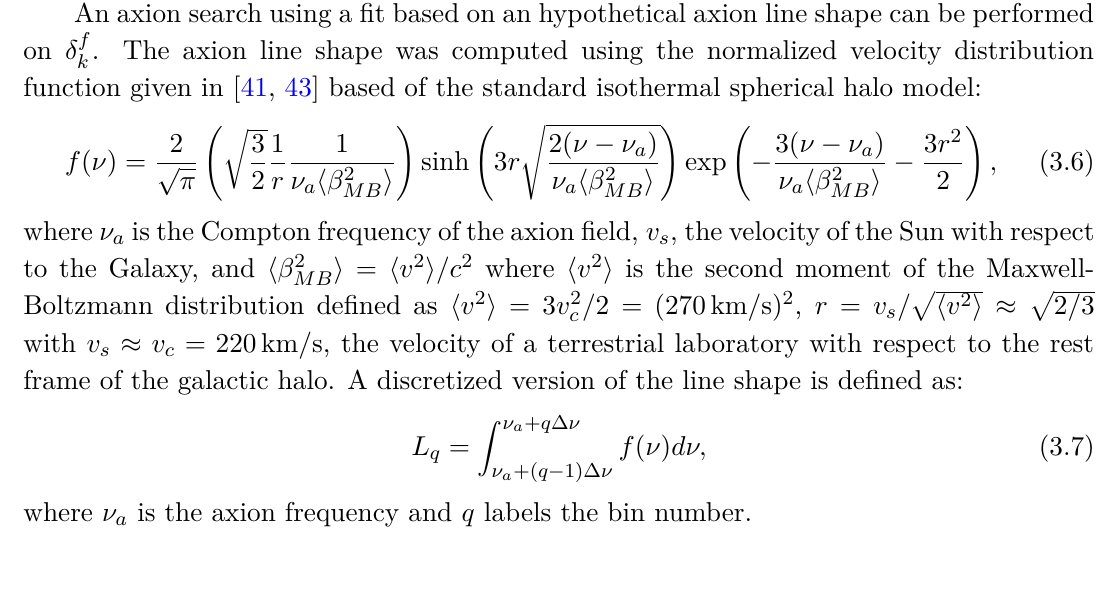
Right: normalized histogram of δ f k